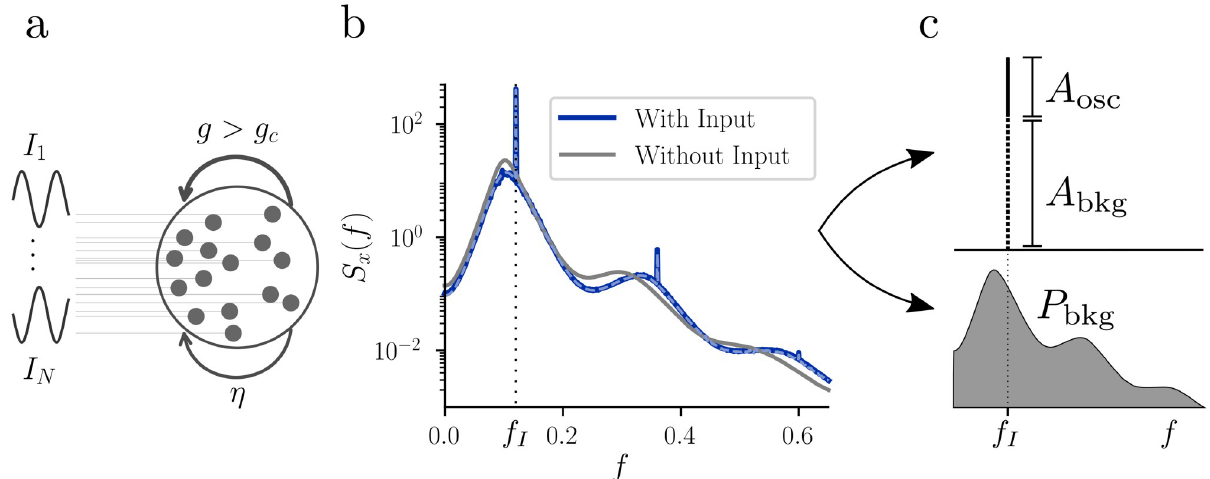
Fig 4. Response of the mean-field network to an oscillatory input. a: Schematic representation of the random network driven by an external input, with phase randomization. For g > g c , the chaotic activity can be seen as internally-generated noise. b: Effect of an oscillatory external input on the ( f ). In the example, γ = 0.25, β = 1, g = 2 g ( γ , β ), f = 0.12, while A = 0.5 (blue) and A = 0 (gray). Simulations (solid blue) and power spectral density S x c I I I theory (dashed blue) are superimposed. c: Top: Schematic representation of the separation of the power spectral density into its oscillatory ( A osc ) and chaotic ( A bkg ) components. Note that these quantities depend on the size of the frequency discretization bin. Bottom: Graphical interpretation of P bkg , i.e. the total variance of the network activity due to chaotic activity (shaded gray